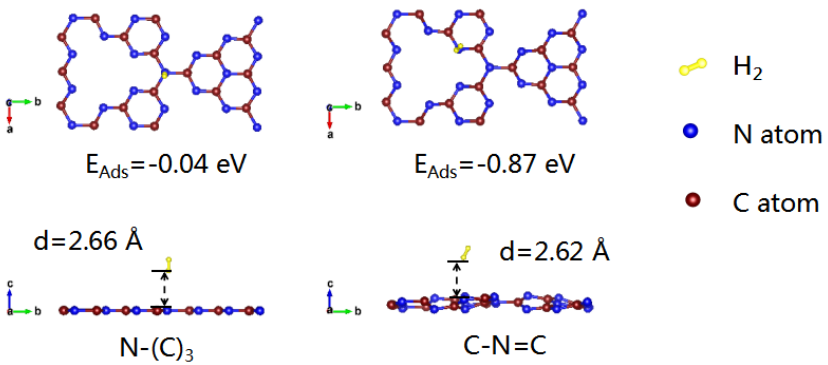
Figure 5. Adsorption energy of hydrogen on N-(C) 3 and C-N=C.